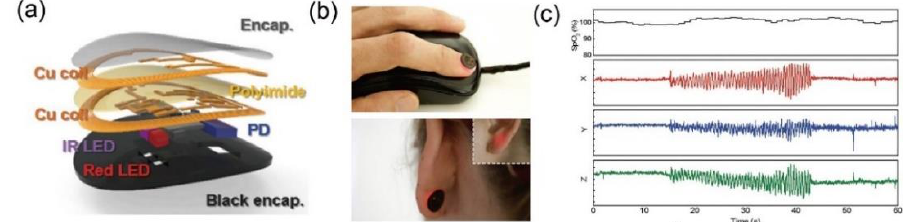
Figure 5. ( a ) Illustration of the various constituent layers of the NFC-enabled pulse oximeter device. ( b ) Photograph image of measurement setup to evaluate SpO 2 level from the fingernail (up). It is possible in application of a device with a computer mouse functioning as a wireless interface. Photograph image of measurement setup to evaluate SpO 2 level from the earlobe (down). ( c ) Calculated SpO 2 during rest and movement on the device. The device quantified the accelerometer’s signal according to the movement in the X(red), Y(blue), and Z(green) axes. Adapted with permission from [31], Wiley, 2016.